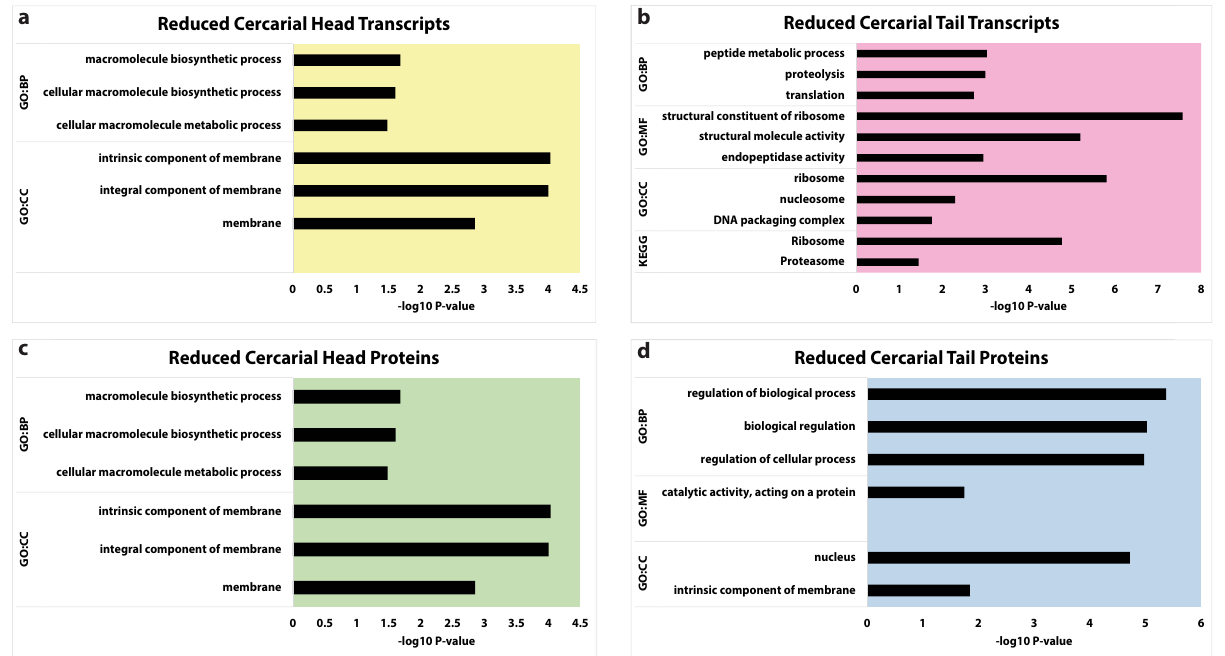
Fig. 5 GO analysis of reduced transcripts and proteins from cercarial heads and tails. Cercarial Tails have a signi fi cant reduction of transcripts related to ribosomal genes and translational maintenance, while cercarial heads show a reduction of both transcript and protein for membrane component genes. All data shown represent reduced categories of differentially expressed genes via GO analysis. a , b shows a reduction of transcript categories for cercarial heads and tails, respectively. c , d shows a reduction of protein categories from cercarial heads and tails, respectively. All supporting data is contained in Supplementary Data